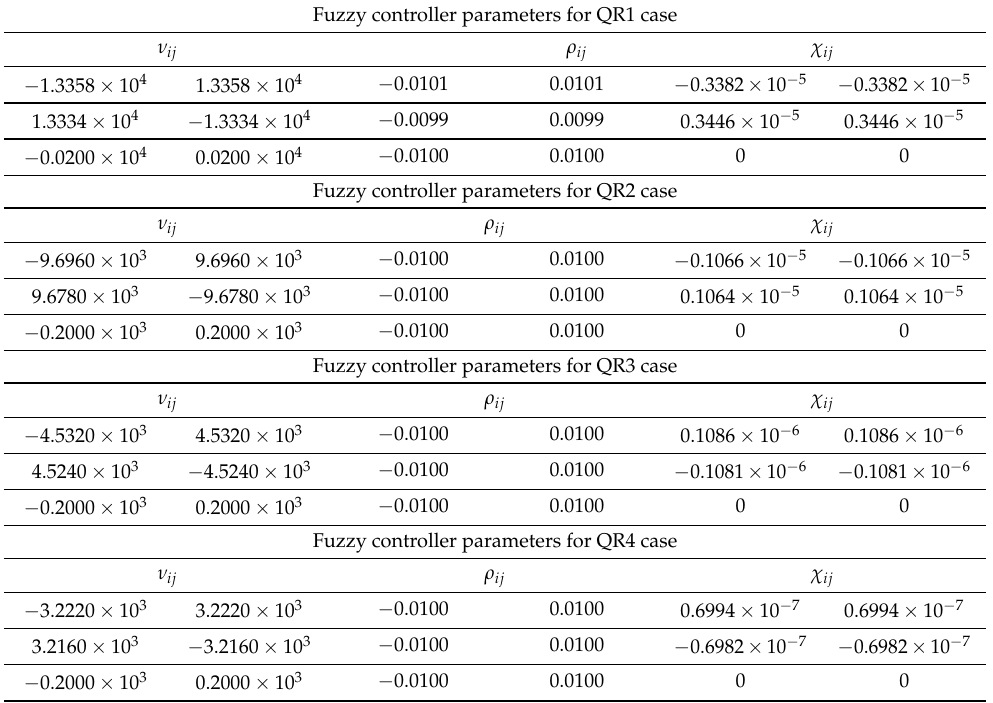
Table 2. Fuzzy controller parameters for QR cases.